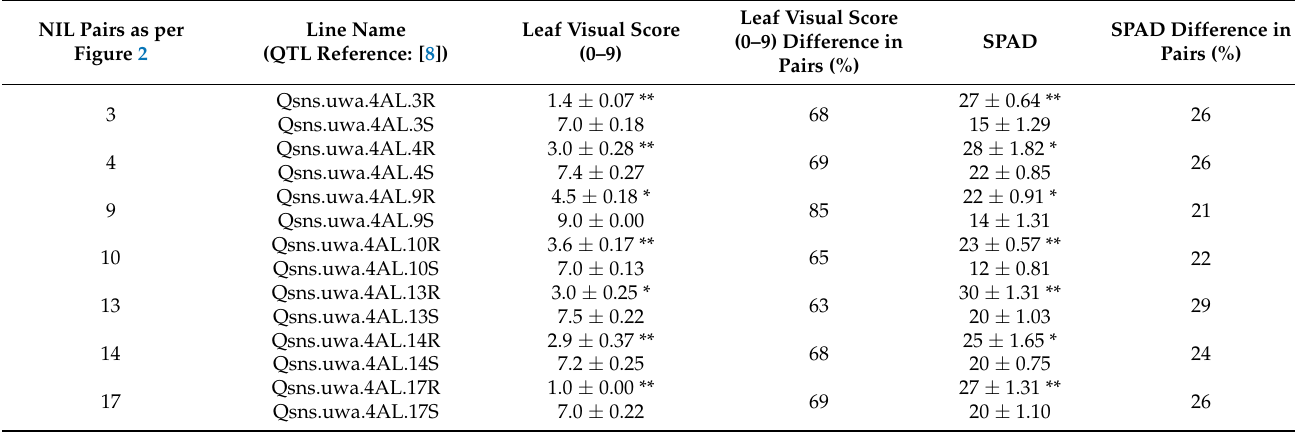
Table 1. Plant leaf visual scores (0–9) and leaf SPAD chlorophyll contents of seven pairs of the confirmed wheat near-isogenic lines (NILs) for metribuzin resistance.